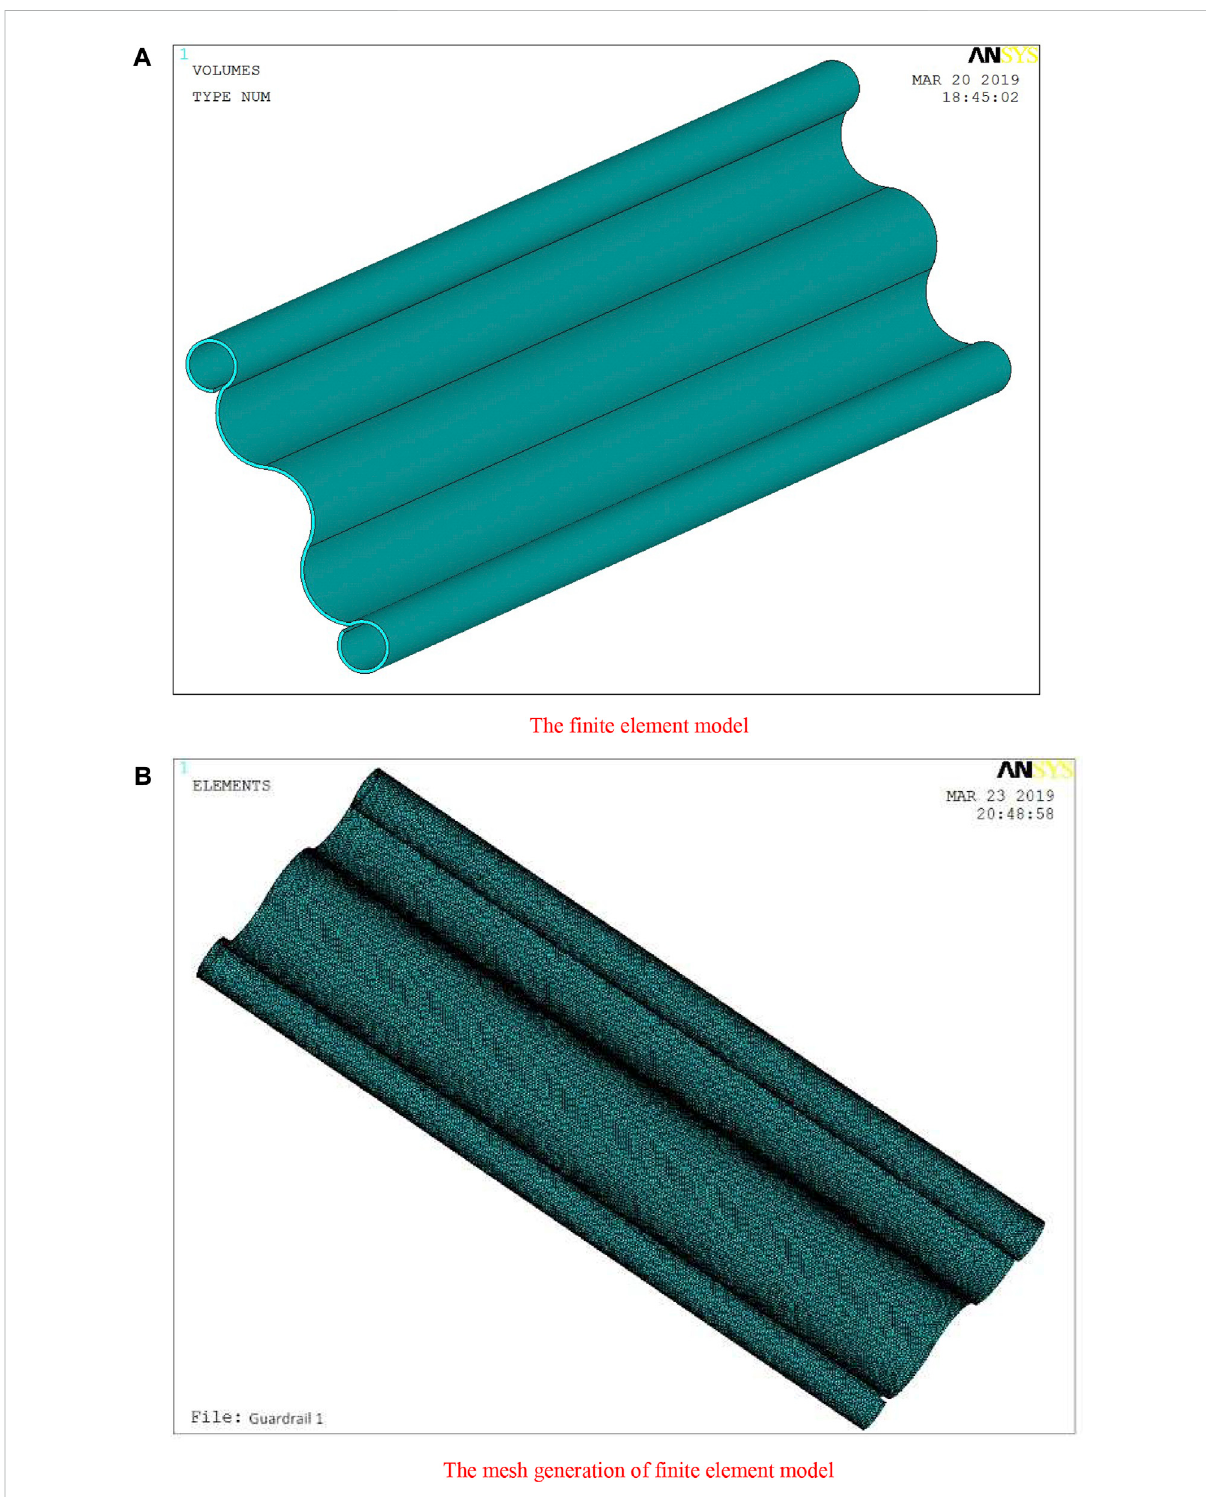
FIGURE 2 Finite element model and mesh generation of the guardrail plate. (A) : Finite element model; (B) : The mesh generation of fi nite element